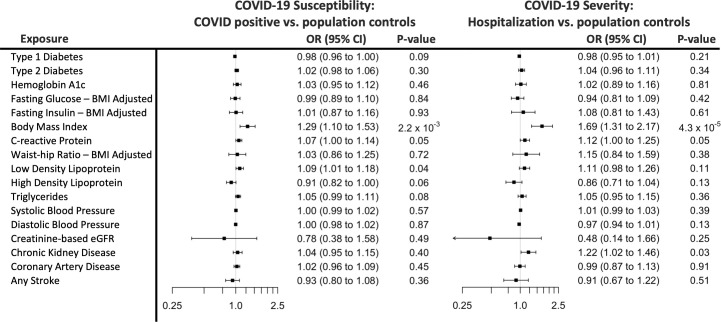
Forest plot Mendelian randomization (MR) effect estimates and 95% confidence intervals for each exposure and the 2 main outcomes analyzed.MR estimates are reported as odds ratios (ORs) per unit of the exposure: hemoglobin A1c, percent unit; fasting glucose, mg/dl; fasting insulin, natural log; body mass index (BMI), inverse normally transformed residuals; waist–hip-ratio, inverse normally transformed residuals; C-reactive protein, rank-based inverse normally transformed; low-density lipoprotein, standardized; high-density lipoprotein, standardized; triglycerides, standardized; systolic and diastolic blood pressure, mm Hg; estimated glomerular filtration rate (eGFR), ml/min/1.73 m2; type 1 diabetes, type 2 diabetes, coronary artery disease, chronic kidney disease, and any stroke, log-odds.